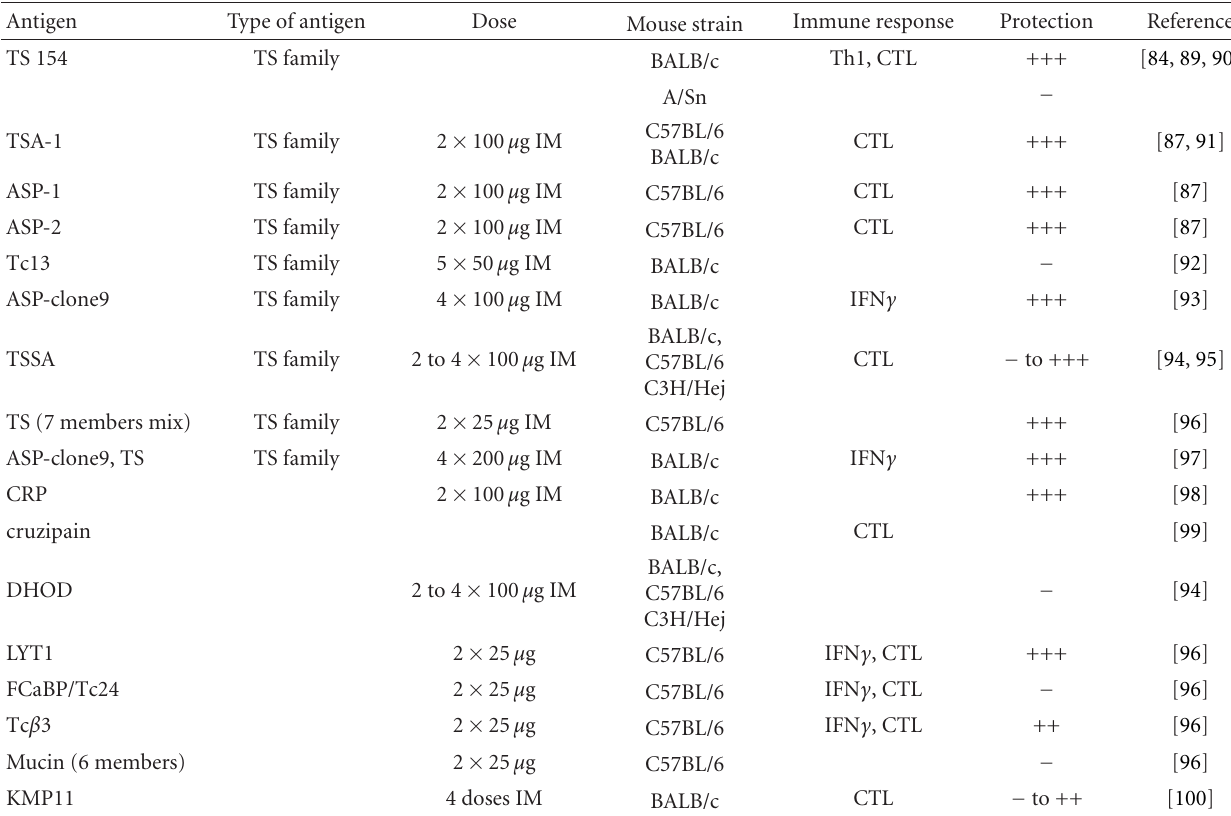
Table 3: DNA vaccines tested against Trypanosoma cruzi